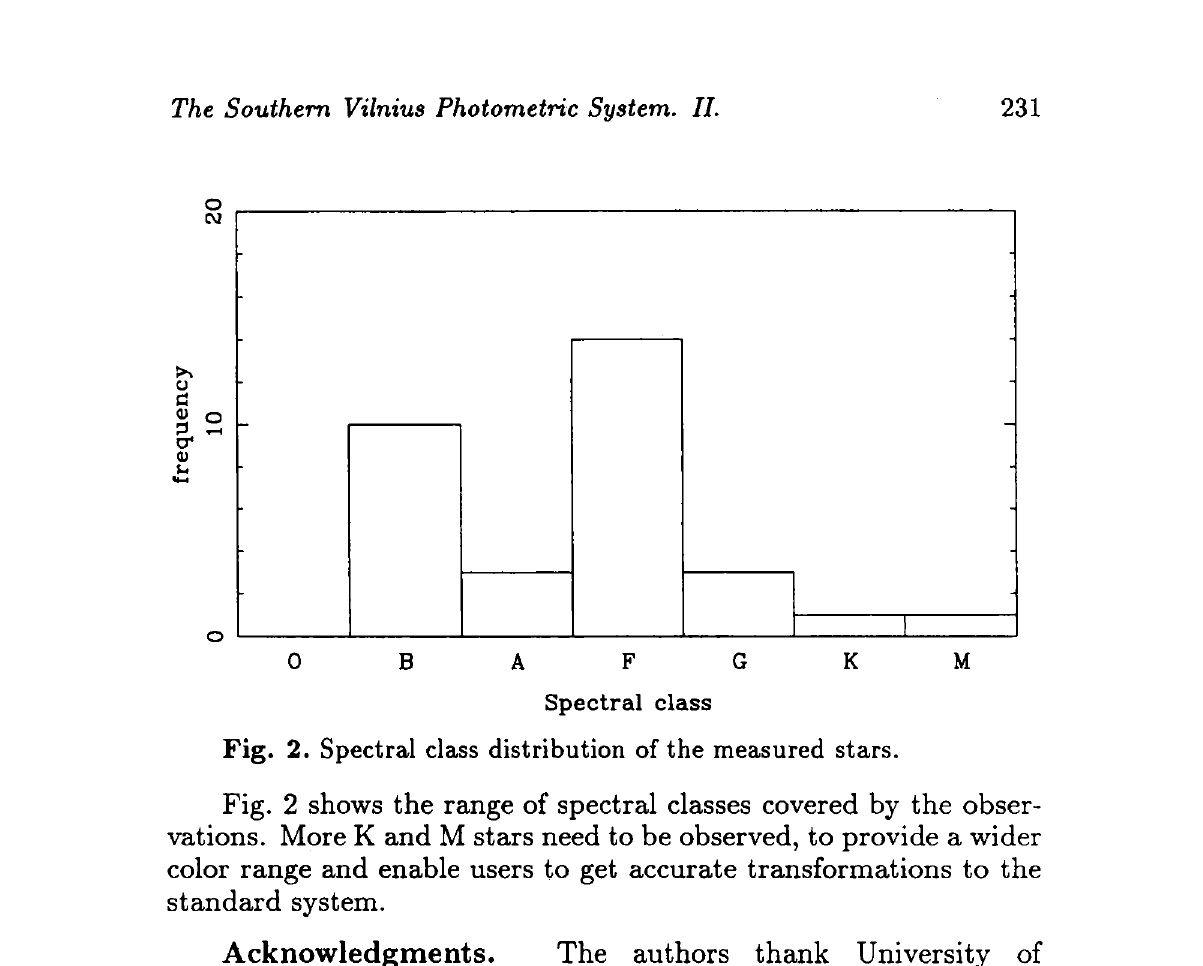
Fig. 2. Spectral class distribution of the measured stars. Fig. 2 shows the range of spectral classes covered by the obser- vations. More K and M stars need to be observed, to provide a wider color range and enable users to get accurate transformations to the standard